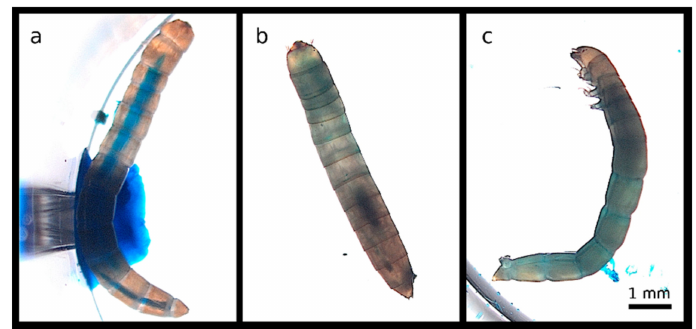
Figure 1. Range of phenotypes exhibited by T. molitor larvae upon ingestion of the positive control diet. ( a ) Healthy control T. molitor larva with a well-defined digestive tract filled with blue-dyed agarose ( b ) Dead larva showing a subtle Smurf phenotype. ( c ) Dead larva showing a strong Smurf phenotype upon ingestion of the positive control diet. The larvae chosen for this experiment were 7–8 mm long and died within one day of exposure. Larva on panel ( b ) retracted after death and appears smaller than its initial size.